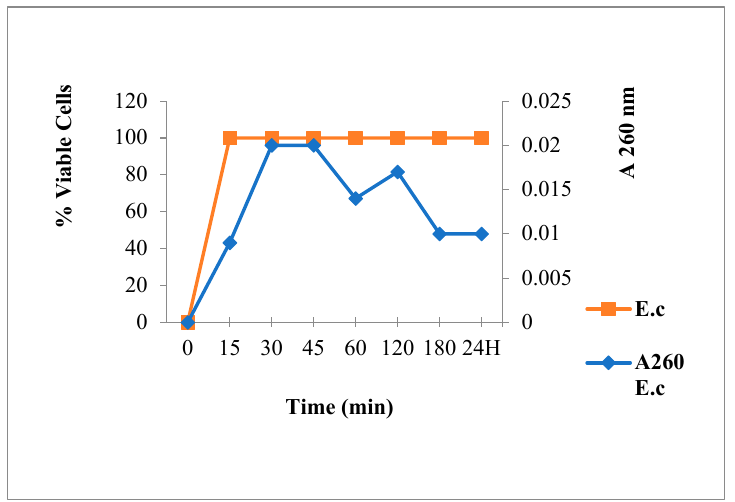
Figure 11. 260 nm absorbent material release and viability of E. coli in absence of antibacterial agent.